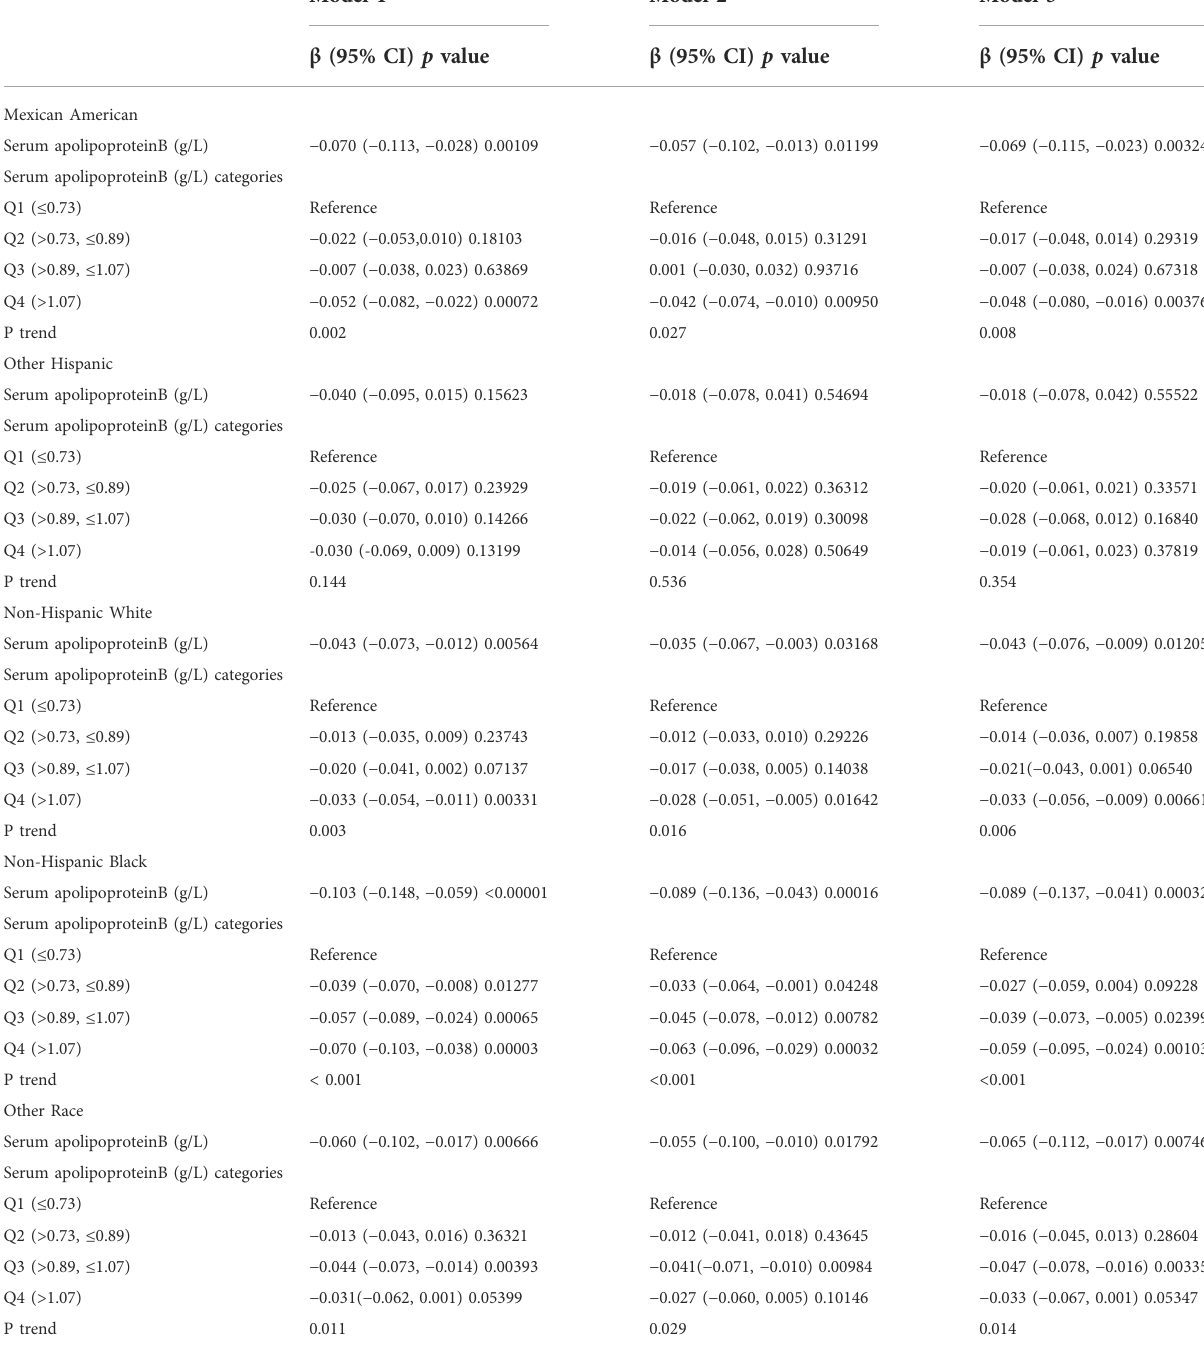
TABLE 5 Association between Serum apolipoproteinB (g/L) and lumbar bone mineral density (subgroup analysis strati fi ed by